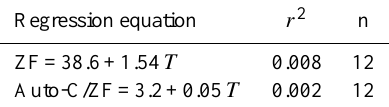
Table 2. Relationships between temperature in ◦ C and microplank- ton biomass, here considered as zooplankton food, ZF, in µgCL − 1 , and the proportion of autotrophs in ZF, Auto-C/ZF. Regression equation r 2 ZF=38.6+1.54 T